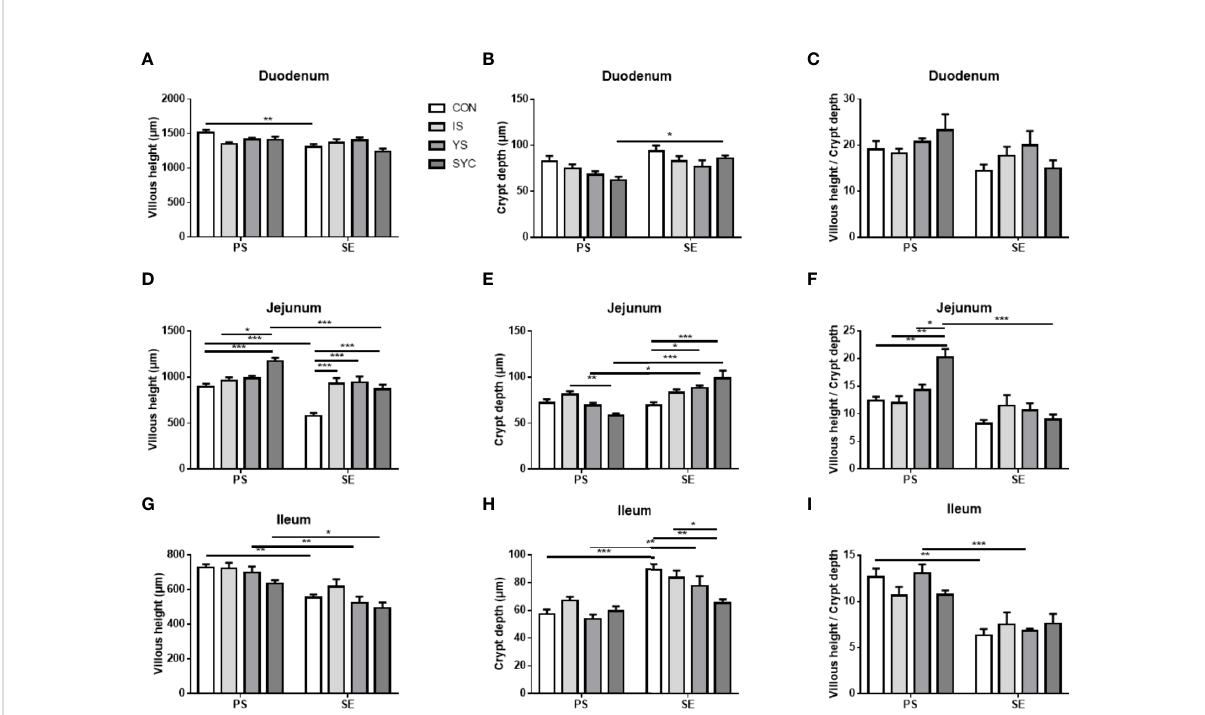
FIGURE 7 Effects of dietary supplementation with different Se sources on histomorphological measurements in the duodenum, jejunum, and ileum of hens challenged with S. Enteritidis . CON, basal diet; IS, sodium selenite; YS, yeast selenium; SYC, selenium-enriched yeast culture; PS, challenged with physiological saline solution; SE, challenged with S. Enteritidis . (A – I) The villus height, the crypt depth, and the villus/crypt ratio were measured randomly in each sample from different groups. The data were presented as mean ± SEM. Signi fi cance was compared with